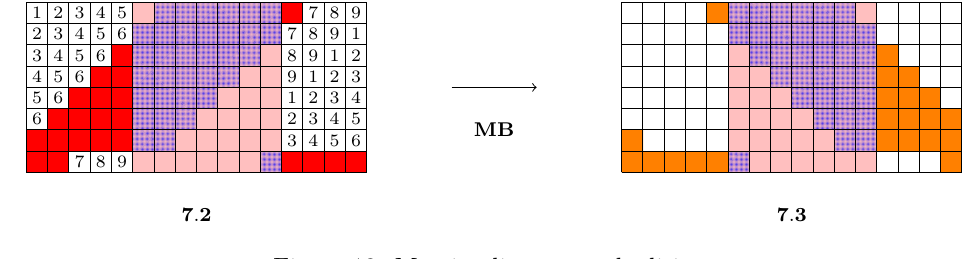
Figure 13: Merging lists, second